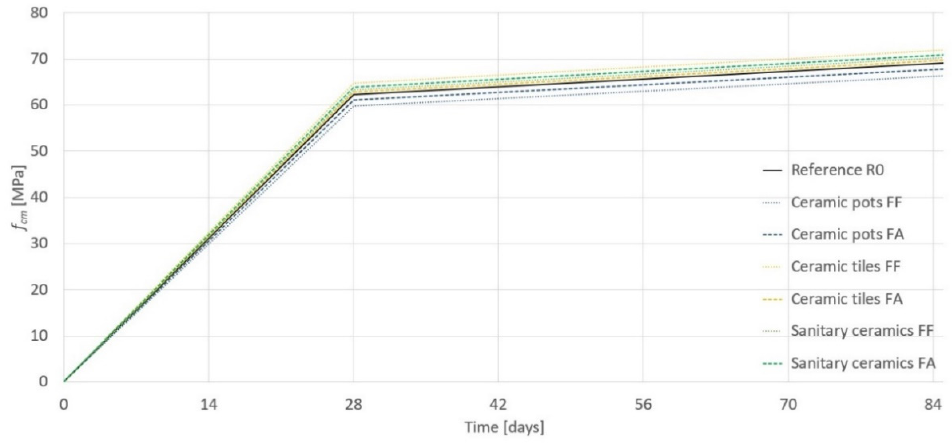
Table 6. The properties of the hardened concretes.